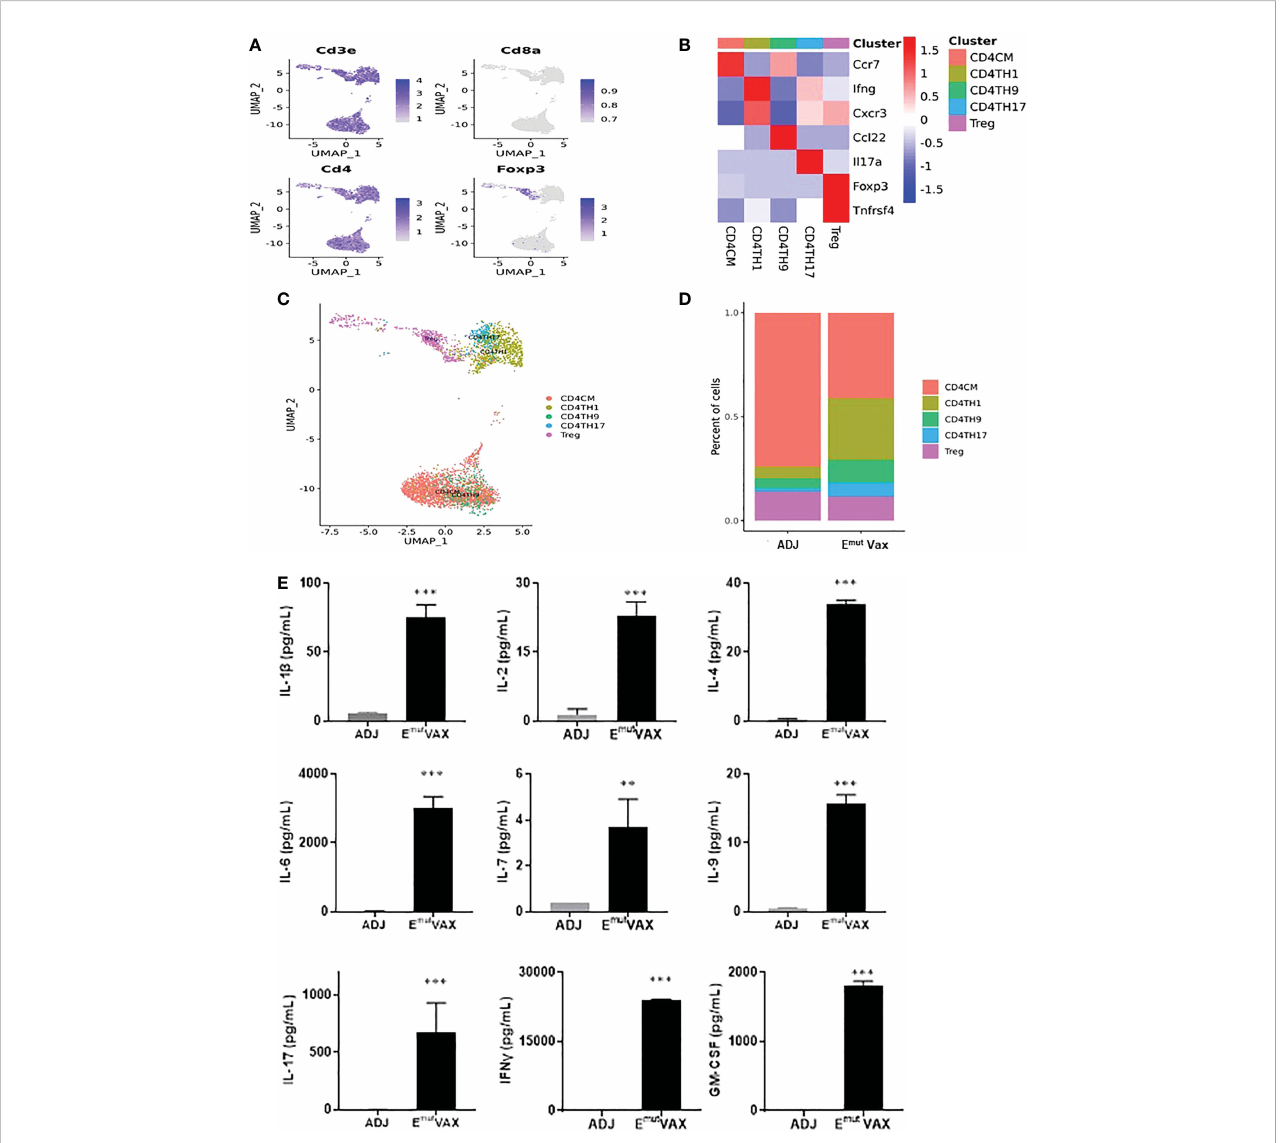
FIGURE 6 E mut Vax treatment stimulated anti-tumor CD4 + effector T cells within tumor-bearing lungs. (A) Canonical CD4 + T cell marker expression based on scRNA-seq data. (B) Heatmap of the expression markers for each CD4 + T cell subset. (C) The distribution of each CD4 + T cell subset. (D) Percent changes of the CD4 + T cell subsets across control and E mut Vax treatment groups. Data are shown as the mean ± SE, n=5, CD4CM: P = 0.032; CD4TH1: P = 0.016; CD4TH9: P = 0.037; CD4TH17: P = 0.046; Treg: P = 0.12. (E) Cytokine analysis from E mut Vax treated mice vs ADJ mice. Splenocytes were harvested at the endpoint, restimulated with E mut peptide vaccines for 72hr, then supernatant was collected for the cytokine analysis. Data are shown as the mean ± SE, n=5, **P ≤ 0.01, ***P ≤ 0.001 vs ADJ